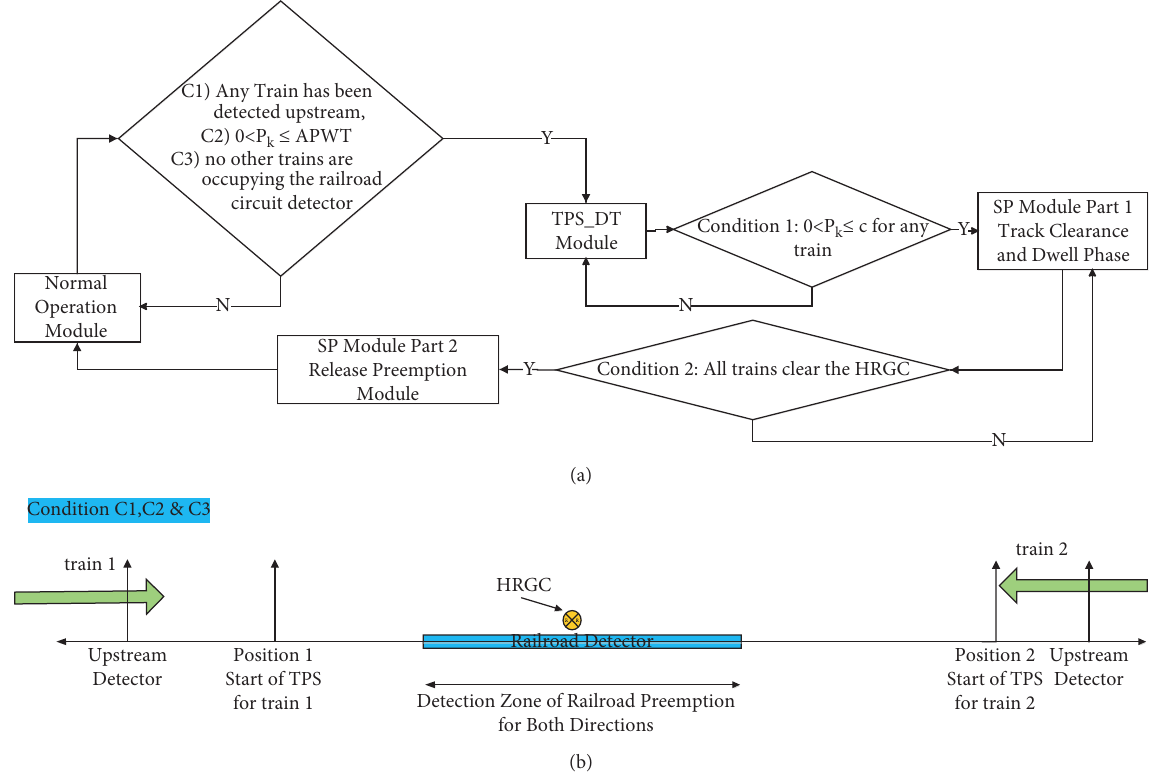
Figure 4: Workflow of the signal controller modules with the integrated TPS_DTalgorithm. (a) Flowchart of the signal controller modules; (b) detector layout for TPS and